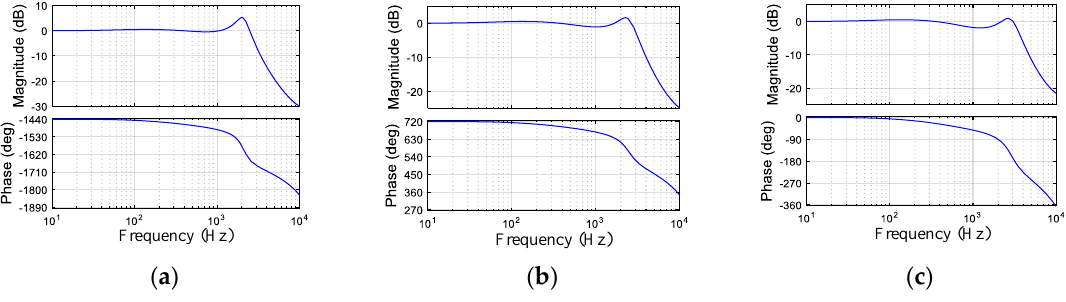
Figure 12. Bode diagrams of voltage closed-loop transfer function: ( a ) r c = 1 Ω; ( b ) r c = 2 Ω; ( c ) r c = 3 Ω.